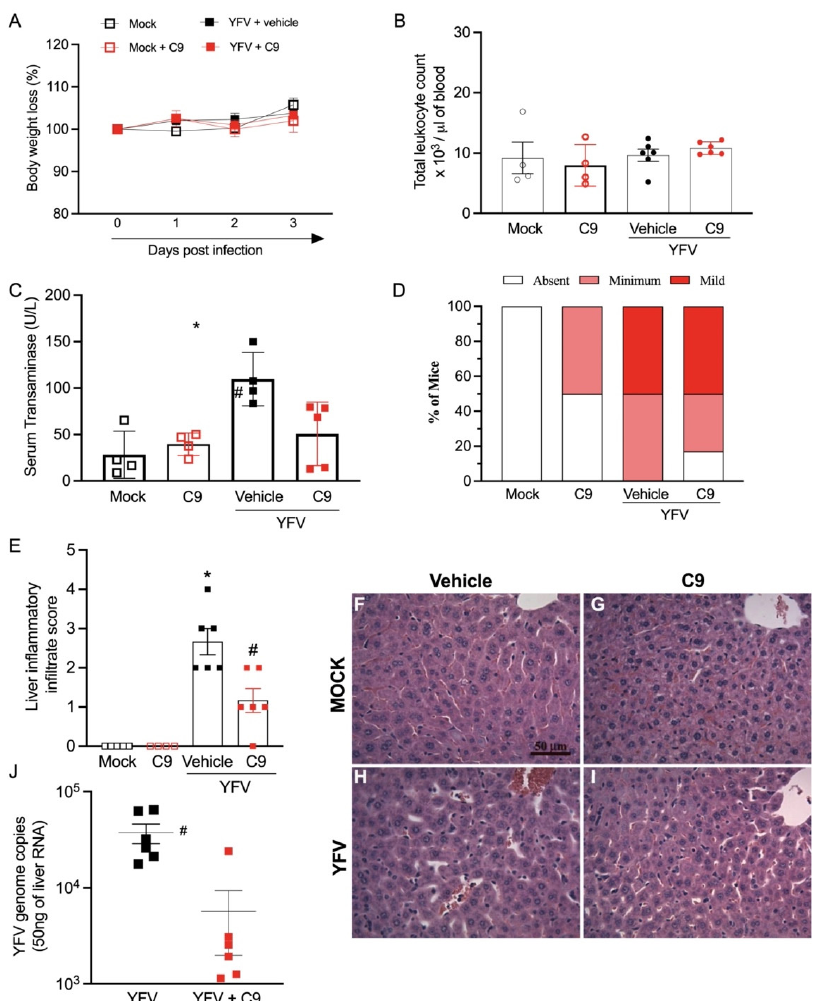
Figure 6. In vivo anti-YFV activity of C9 in A129 mice. Adult (8–10 weeks old) A129 mice were infected i.v. with 10 6 PFU/100 µL of YFV virus (YFV 17D strain). Daily intraperitoneal injections of C9 (10 mg/kg) were started 1 hr post-infection and continued until 3 days post-infection (dpi). Mice were euthanized 6 hr after the last treatment with vehicle or C9 on day 3 post-infection. Blood and tissues were collected and processed for further analysis. Groups were composed of six mice, three males, and three females. ( A ) Body weight change post-infection was assessed by two-way ANOVA plus Sidak’s multiple-comparison test. Data are shown as mean ± SEM, n = 6. ( B ) Changes in the number of circulating total leukocytes 3 days post-inoculation, represented as box plots. Data from each group were compared with those from the mock or mock + C9 groups by one-way ANOVA plus Dunnett’s multiple-comparison test data shown as mean ± SEM, n = 6. ( C ) Estimation of liver dysfunction analyzed by serum concentration of alanine aminotransferase (ALT). Results are expressed as U/L. Statistical differences among groups were assessed by one-way ANOVA plus Tukey’s post hoc test data shown as mean ± SEM, n = 6. ( D ) Percentages of mice according to the grade of inflammatory cell infiltration in the liver. ( E ) Histopathological assessment in relation to overall inflammatory score. Comparisons between mock and mock + C9 and infection groups were carried out by Kruskal-Wallis plus Dunn’s post hoc test data shown as mean ± SEM, n = 6. ( F – I ) Representative H and E-stained liver slices of mock ( F ), mock + C9 treated ( G ), YFV + vehicle ( H ), and YFV + C9-treated mice ( I ) at 3 dpi. Scale bar: 100 µm. ( J ) Quantitative RT-PCR analysis of YFV viral load in the mice livesr tissue 3 days after YFV inoculation. Data shown as mean ± SEM, n = 6; * p < 0.01 in comparison to the non-infected (mock) group,; # p < 0.01 when comparing YFV + C9 to YFV group using unpaired t